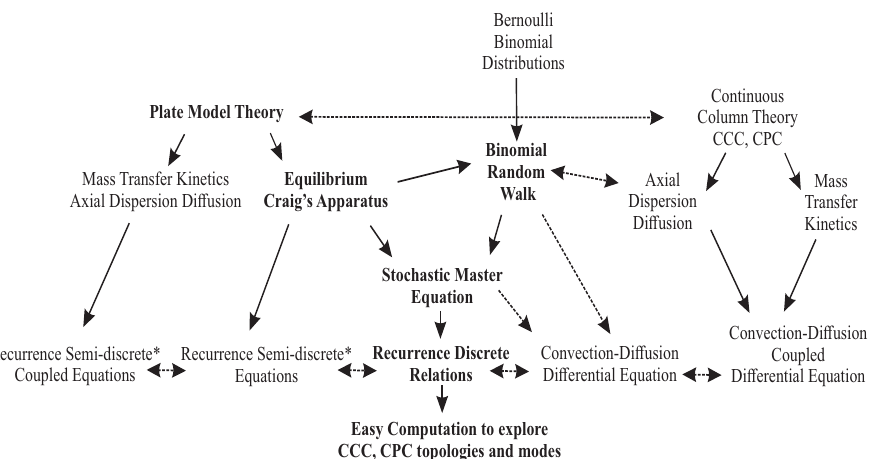
Figure 1. Flowchart of the different modeling methods for liquid–liquid chromatography (*semi- discrete or discrete-continuous mean with a time derivative and space discrete difference). The central path (in bold) is the vein of the